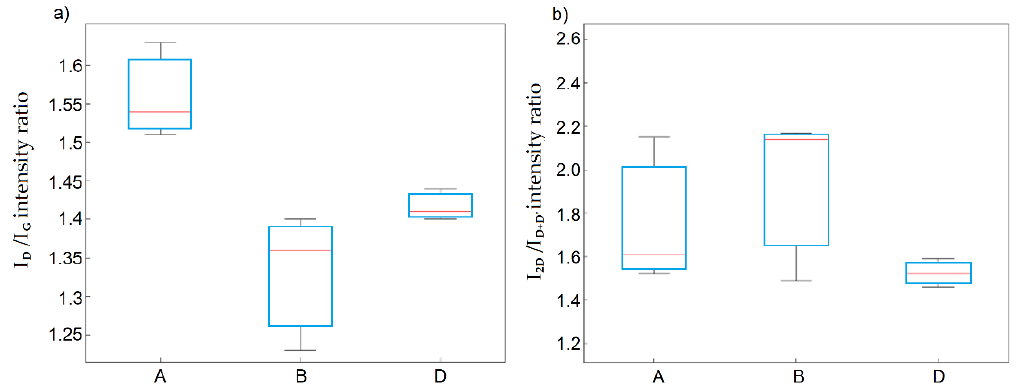
Figure 12. Box plots of ( a ) I D /I G and ( b ) I 2D /I D+D’ ratios as functions of the applied method. For materials obtained from flake graphite, as the graphite layers’ size in the graphite precursor increased, the I D /I G ratio decreased and the structural defects in their structures also decreased. This was confirmed by the highest share of C sp 2 being observed in the reduced graphene oxides obtained from flake graphite. The ANOVA also confirmed this observation. The precursor’s effect on the carbon content with C in sp 2 hybridization was statistically significant (Figure